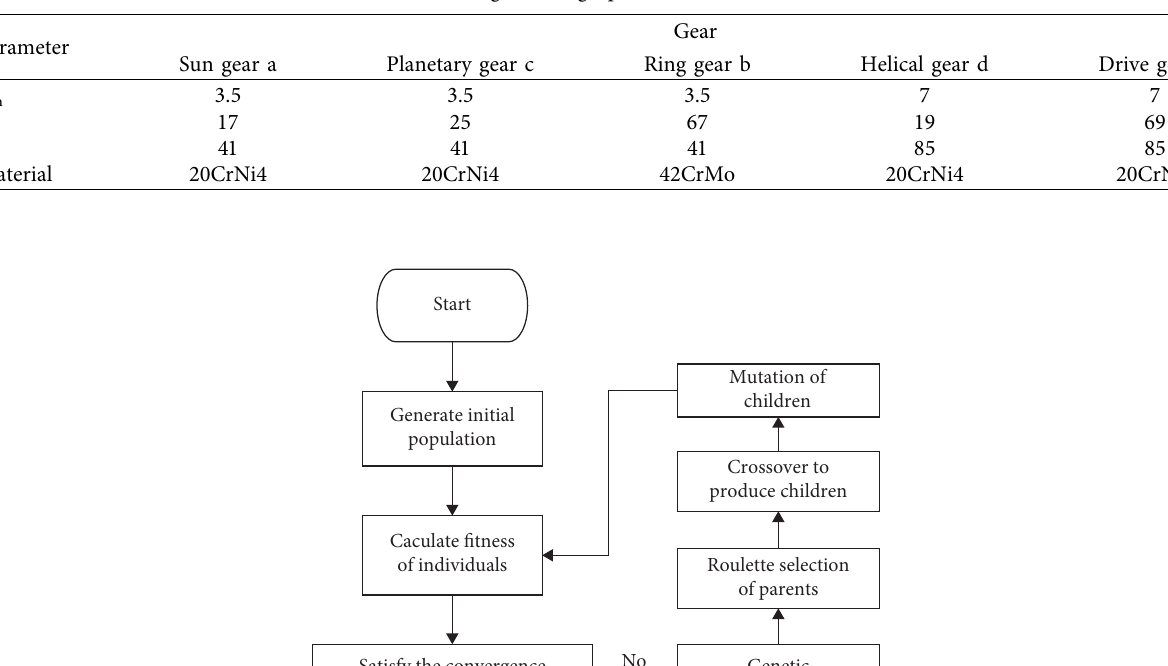
Figure 1: Transmission diagram of reduction gearbox. Table 1: Original design parameters of reducer.